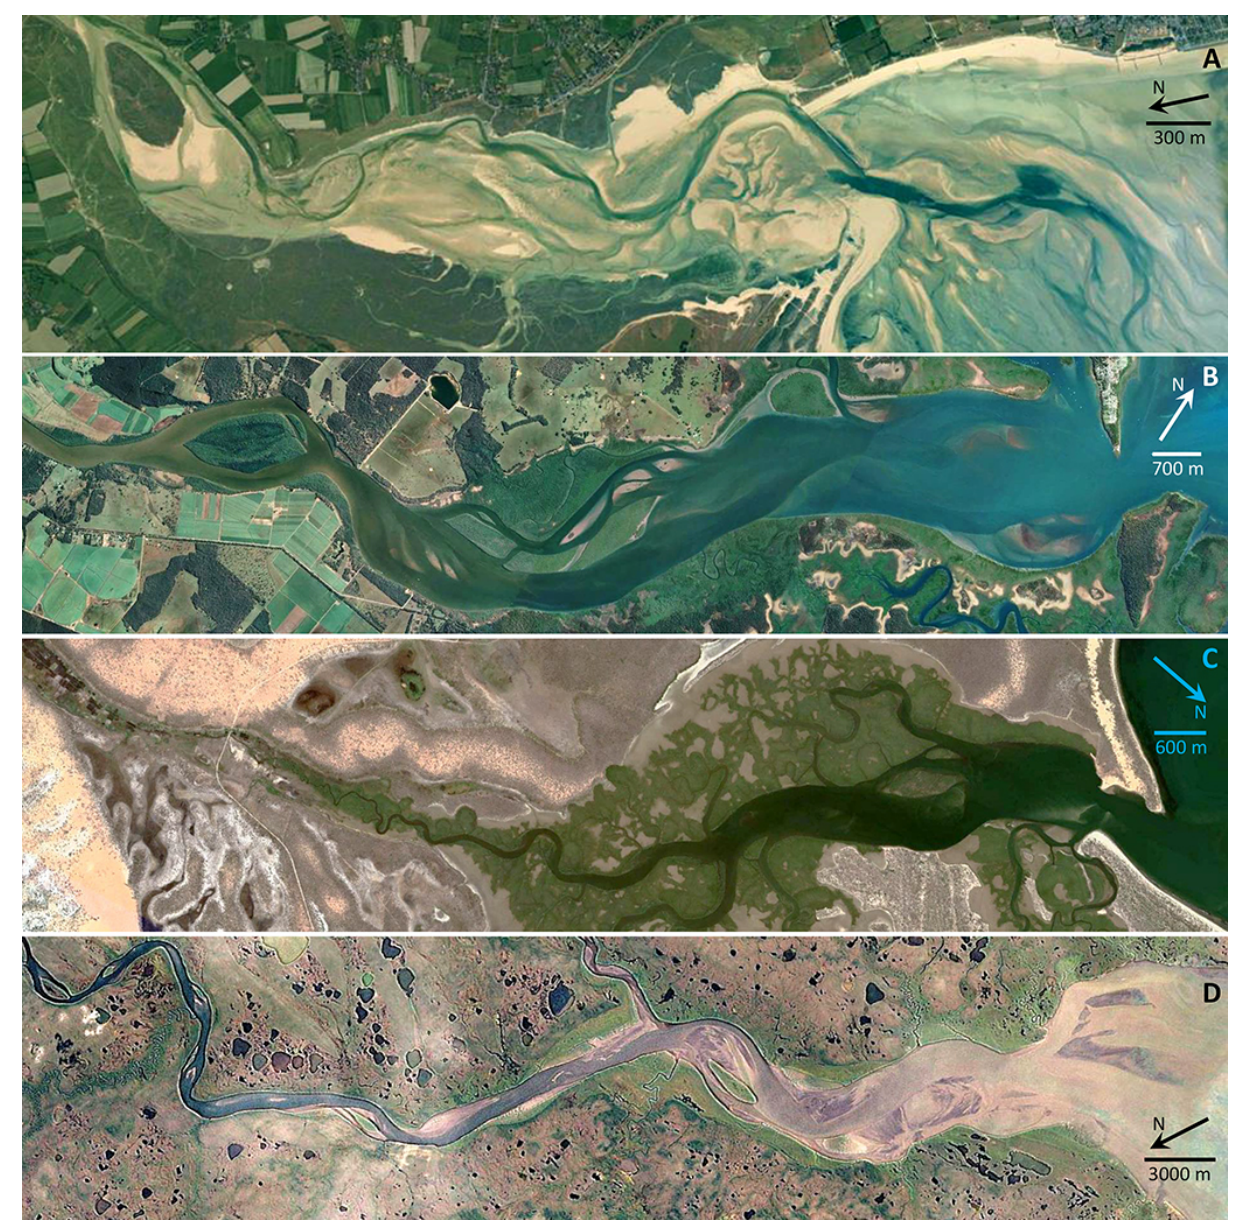
Figure 1. Example estuaries with mid-channel bars that have vegetated flanks and bars. (a) Sienne estuary, western Normandy, France, May 2010. (b) Mary River, SE Queensland, Australia. Note upstream increasing sediment concentration and mudflats near the mouth. Image from 6 July 2021. (c) Mangolovolo estuary, SW Madagascar. Image from September 2016. (d) Levelock Creek, Alaska. Note the extensive muddy bars. Image from December 1999. All images are from Google Earth and were accessed 5 August 2021 and contrast stretched as a whole. © Google